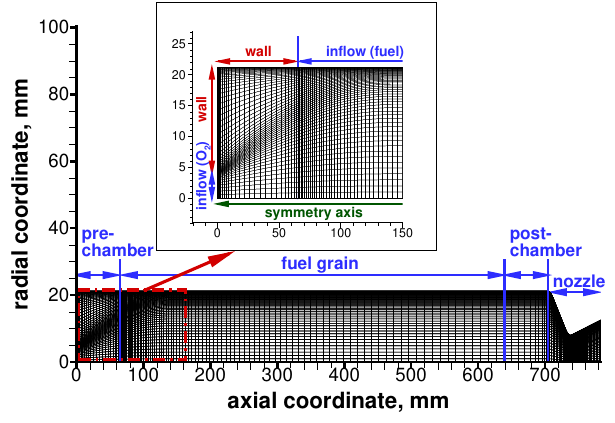
Figure 2. Numerical grid schematic (not to